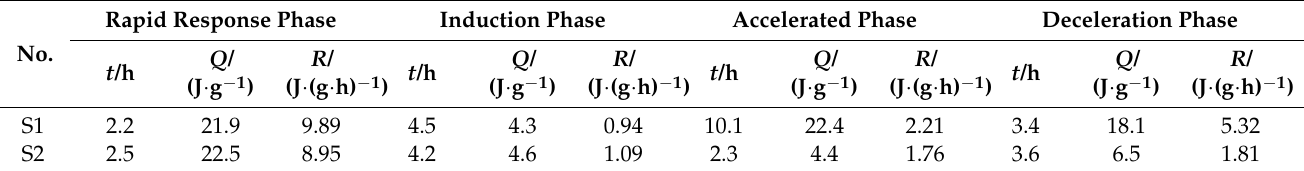
Table 7. Classification of the exothermic stages of hydration and the heat release and exothermic rate of each